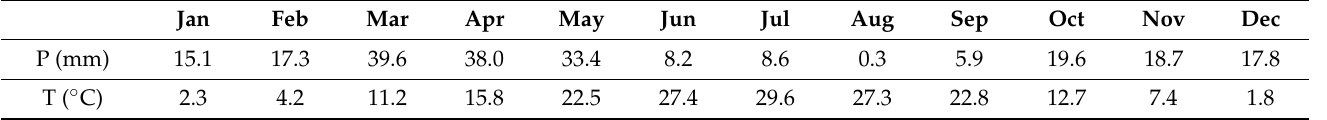
Table 1. Temperature and precipitations in Ghafurov region in 2001–2020.